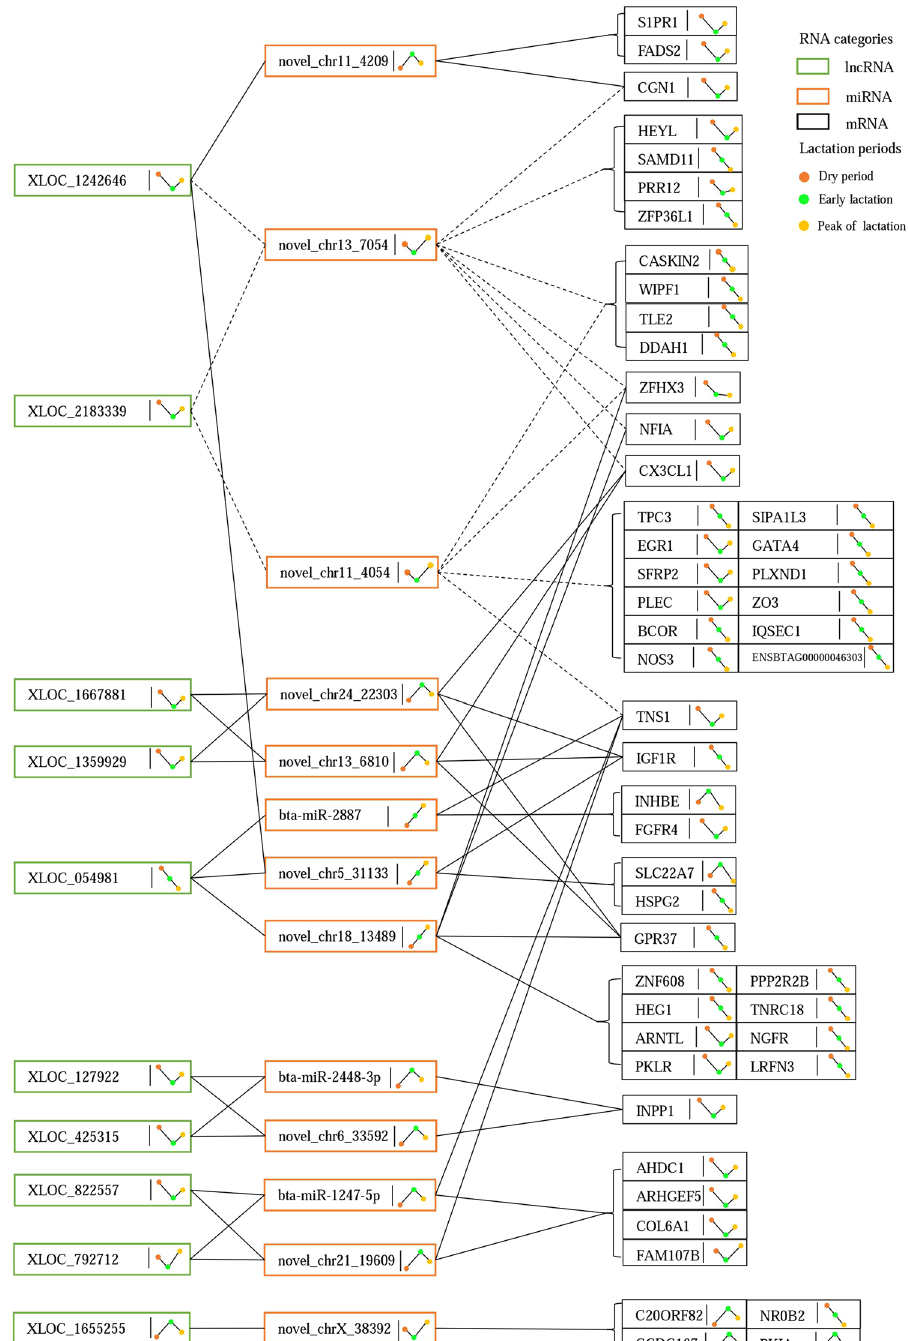
Figure 2. Definite expression of RNAs in ceRNA networks profiling their dynamic expression trends. The definite expression of lncRNAs, miRNAs, and mRNAs are shown based on FPKM, TPM, and FPKM values, respectively; green, orange, and black rectangles represent lncRNAs, miRNAs, and mRNAs, respectively; red, green, and yellow dots represent dry period, early lactation, and peak of lactation, respectively; the lines linked by these color dots show the dynamic expression trends of RNAs during periods; the full lines mean that interactions between RNAs follow the ceRNA regulatory mechanism; and the dash lines mean that the interactions between RNAs do not obey the ceRNA regulatory